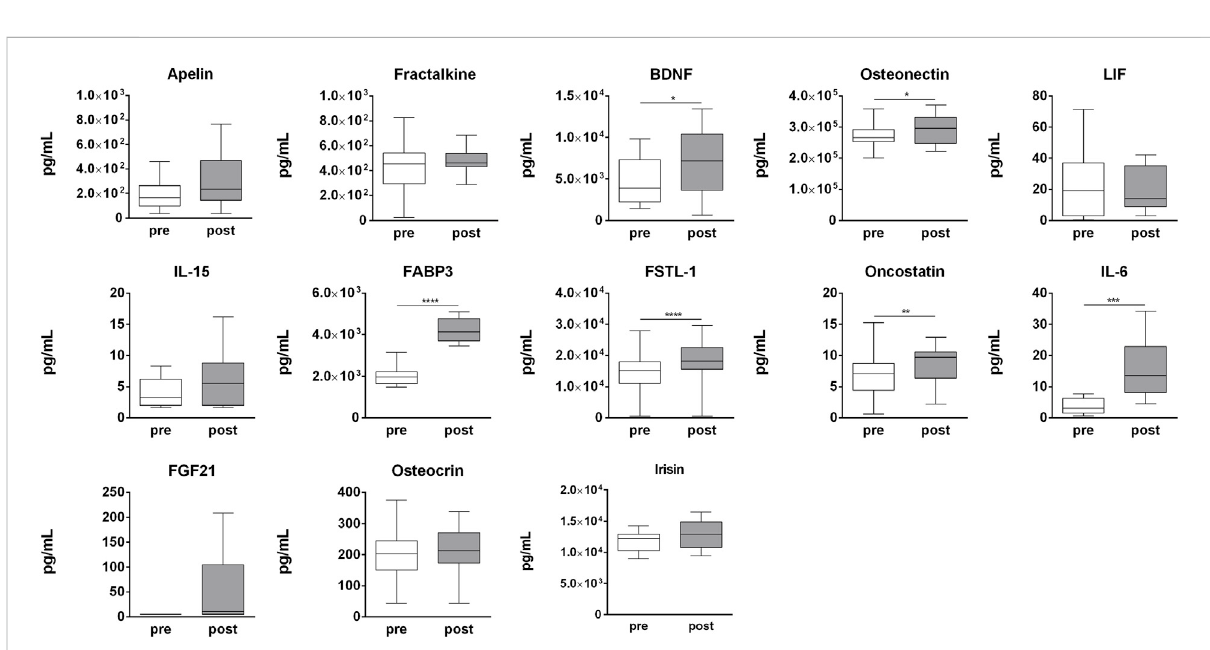
FIGURE 8 Myokinesplasmapro fi le.Changesinmyokinespro fi leinpre-competitionvs.post-competitionsamples.Statisticalanalysiswasperformedwith Prism ® v6.01 (GraphPad Software). All data are expressed as min. to max. and compared using a paired t -test. The differences were considered signi fi cant when p < 0.05. Asterisks indicate signi fi cant intergroup differences (* p < 0.05, ** p < 0.01, *** p <